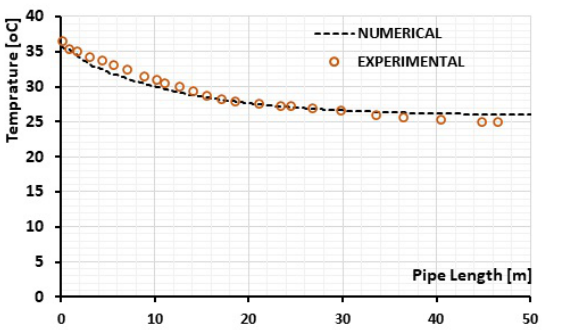
Fig. 9. Numerical temperature distribution in the pipe, versus experimental data obtained in [23]